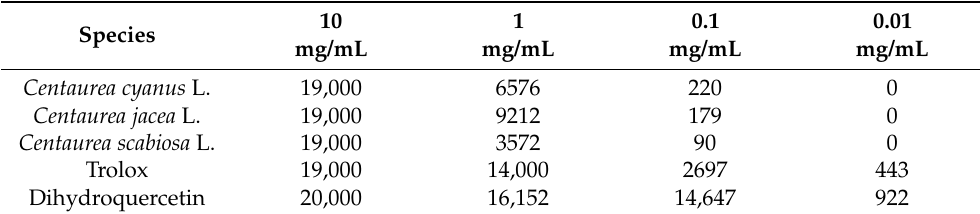
Table 6. TAR of ethanol extract from Centaurea L. flowers.